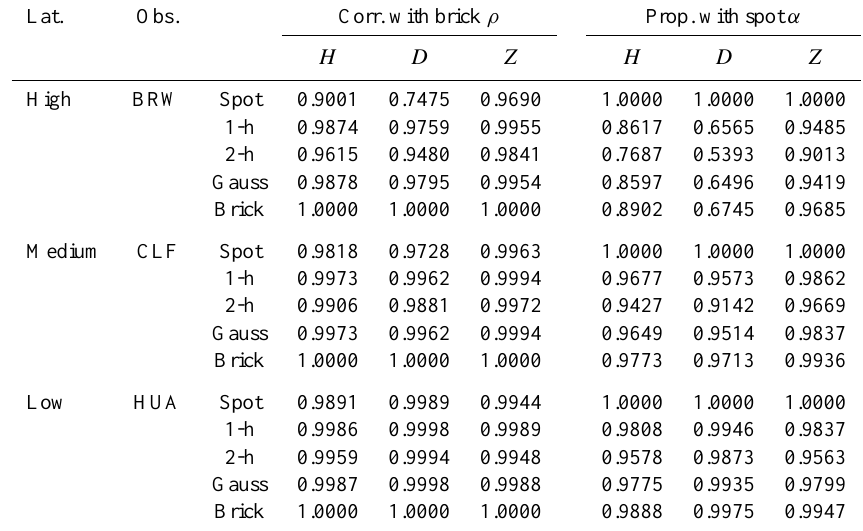
Table 5. Correlations with brick-wall average samples and proportionalities with spot samples, 1998.0–2009.0. Lat. Obs.